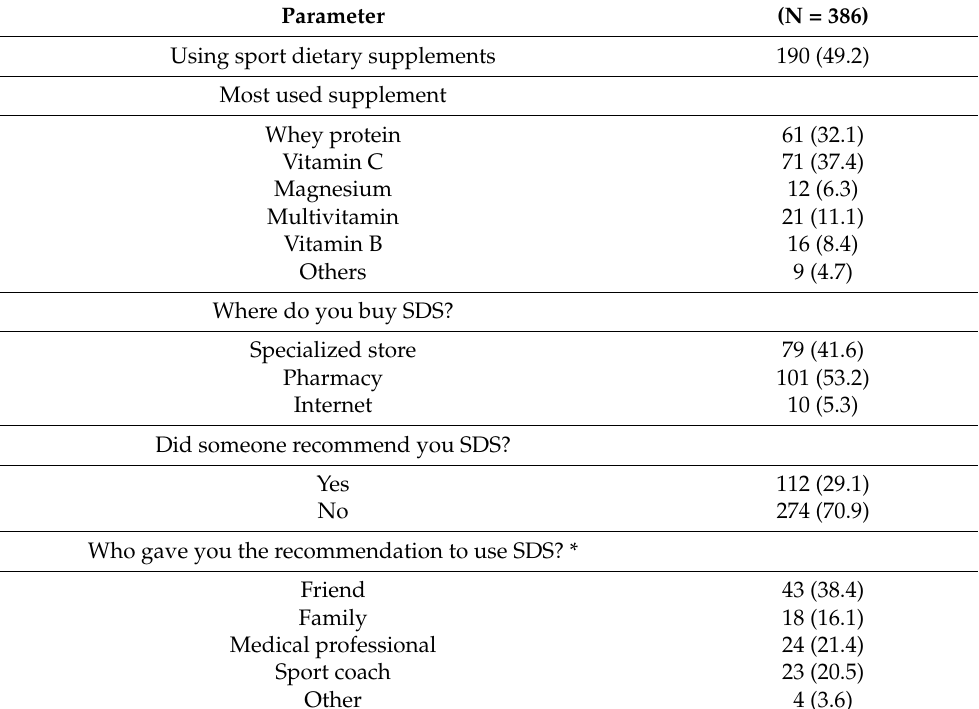
Table 3. Habits about sport dietary supplement (SDS) usage in the study